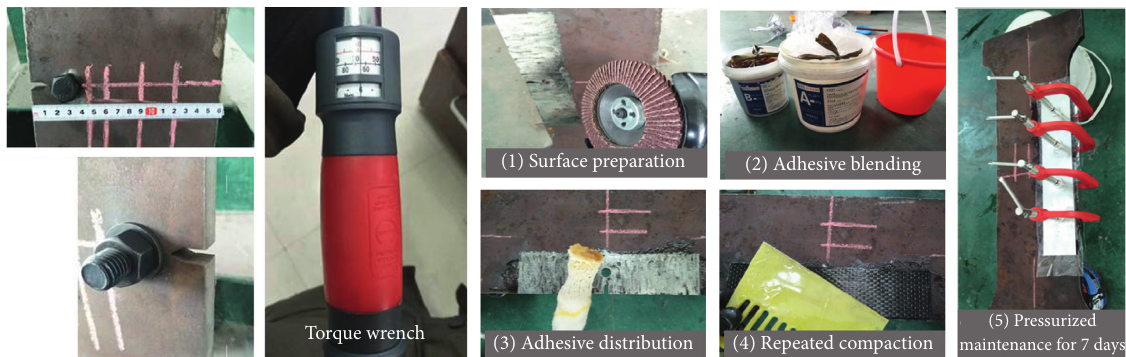
Figure 14: High-strength bolt repair group and CFRP repair